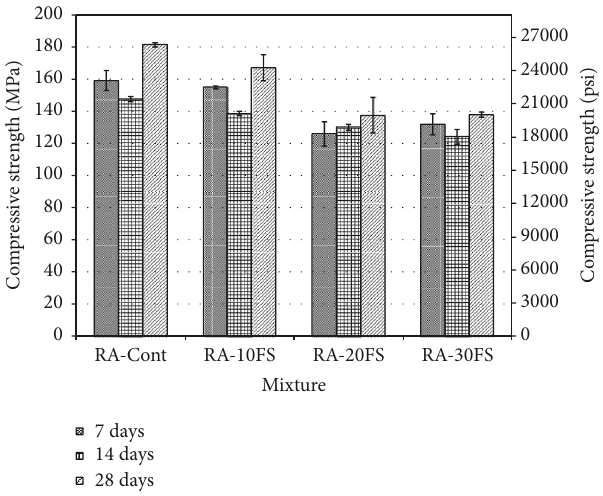
Figure 2: Compressive strength of reactive sand: foundry sand mixtures at 7, 14, and 28